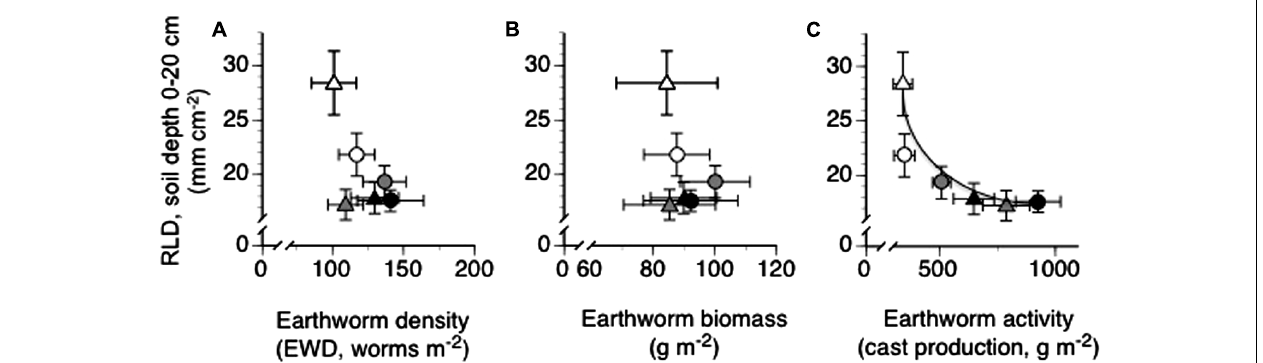
FIGURE 3 | Relationships between mean annual root length density (RLD) and mean annual earthworm density (A), mean annual earthworm biomass (B) and mean cumulative annual earthworm activity – cast production (C) in trenched grassland plots with manipulated earthworm densities (EWDs) under ambient and increased rainfall (means ± SEs,